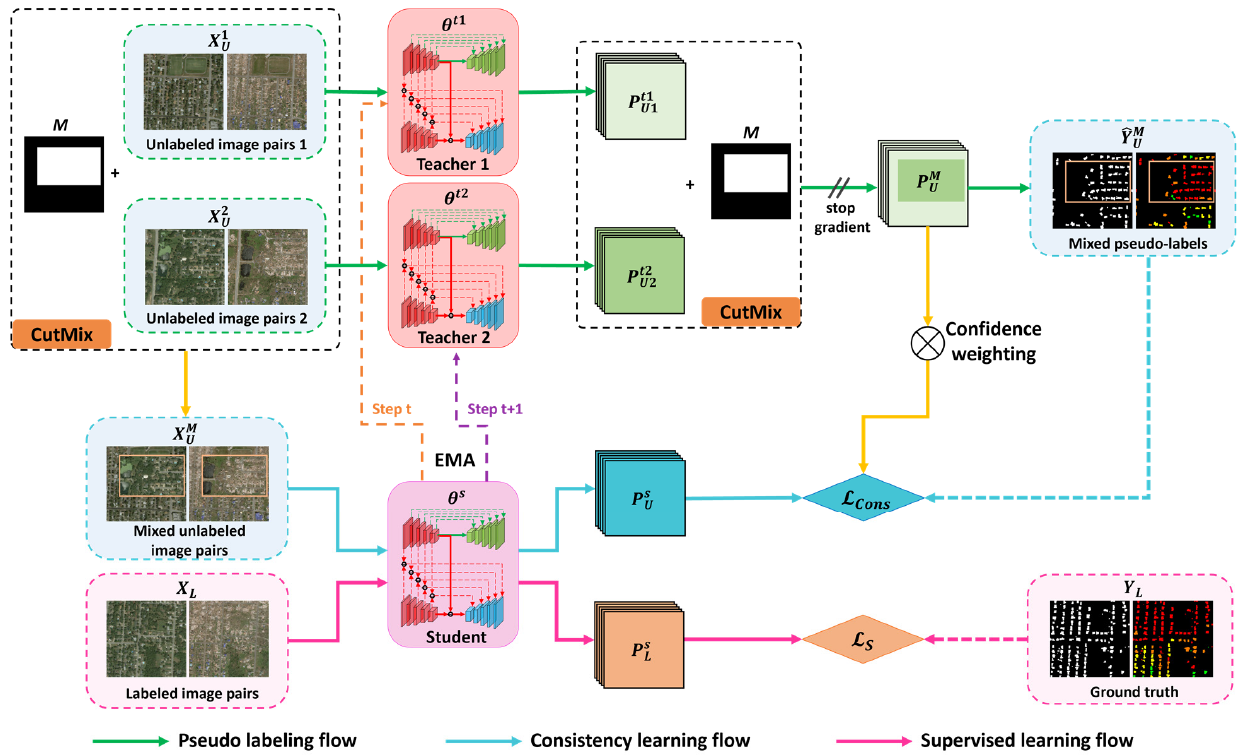
Figure 4. Illustration of the proposed SSL framework for building damage assessment.